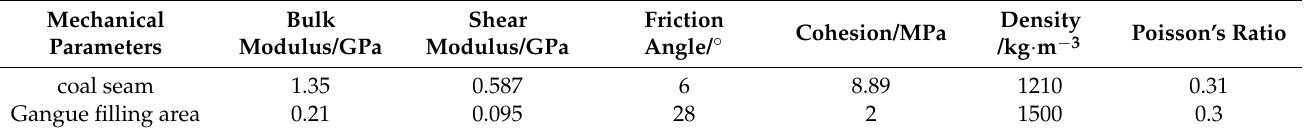
Table 7. Physical and mechanical parameters of the filling